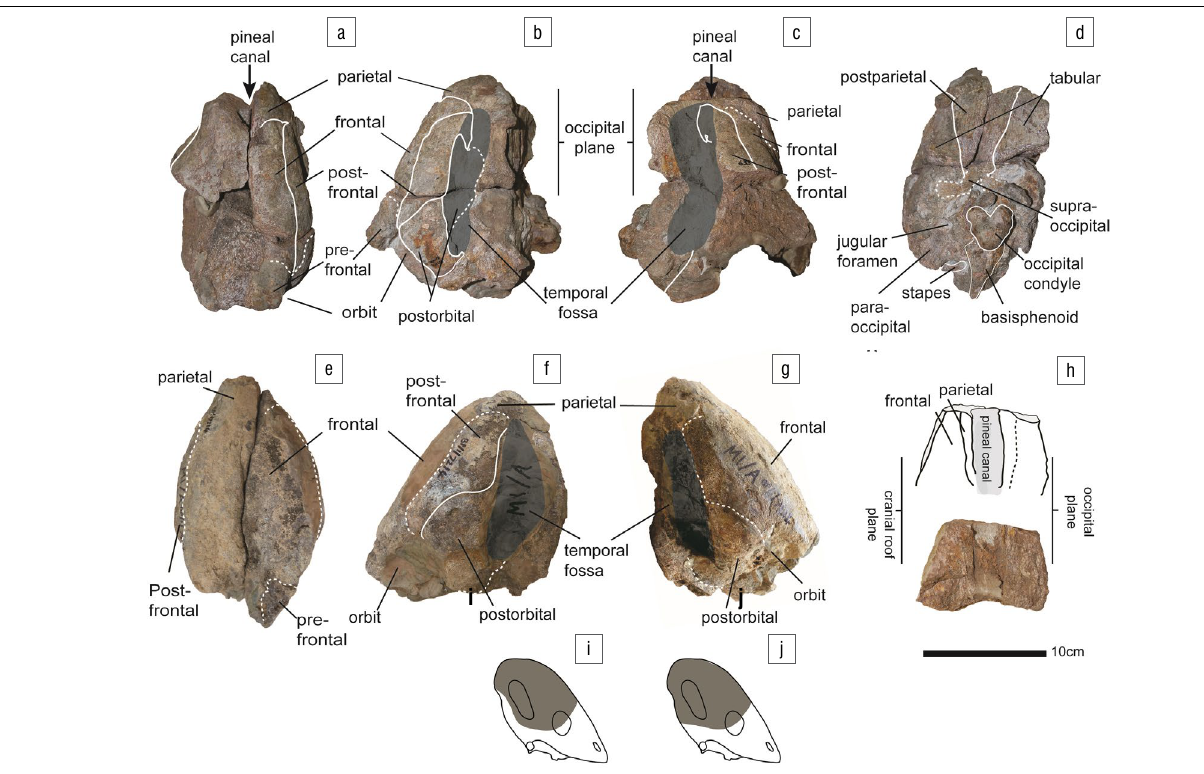
Figure 3: Photos of the specimens (a–d) SAM-PK-K10888 and (e–g) BP/1/7214 showing (a,e) dorsal view, (b,f) left lateral view, (c,g) right lateral view and (d) occipital view. (h) View of sagittal plane on right posterior part of the skull of SAM-PK-K10888, showing the pineal canal orientated parallel to the occipital plane. (i, j) Idealised skull of Criocephalosaurus (redrawn from Boonstra 14,28 ) showing the portions preserved in (i) BP/1/7214 and (j) SAM-PK-K10888.